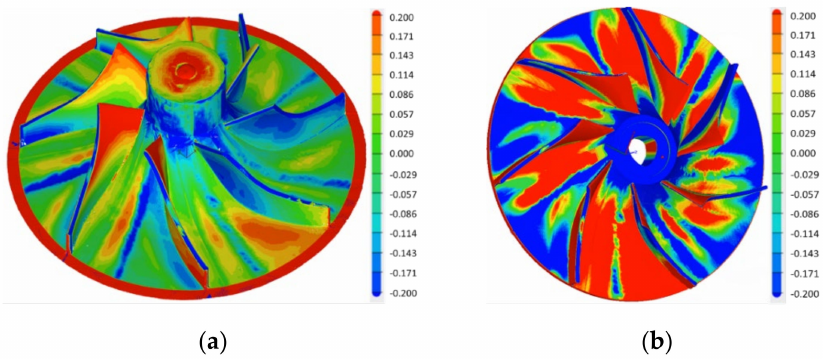
Figure 16. Composite impeller dimensional accuracy after ( a ) first and ( b ) second manufacturing phase.